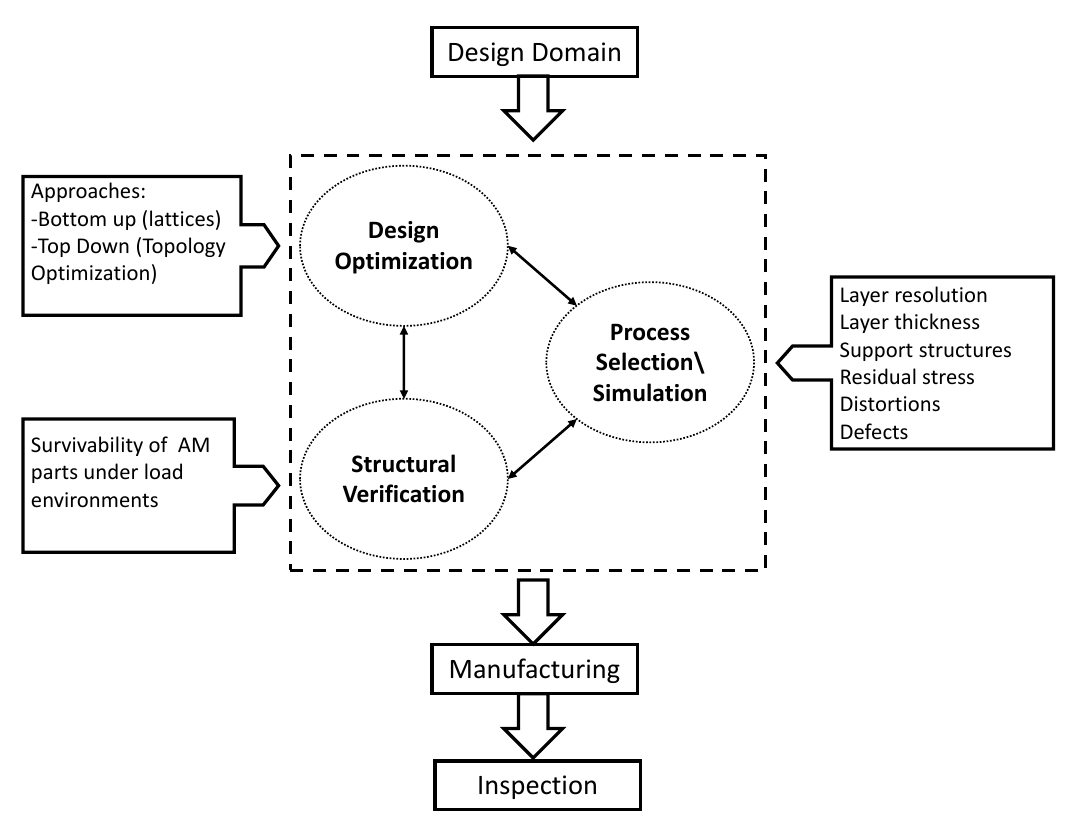
Figure 1. Overview of AM engineering